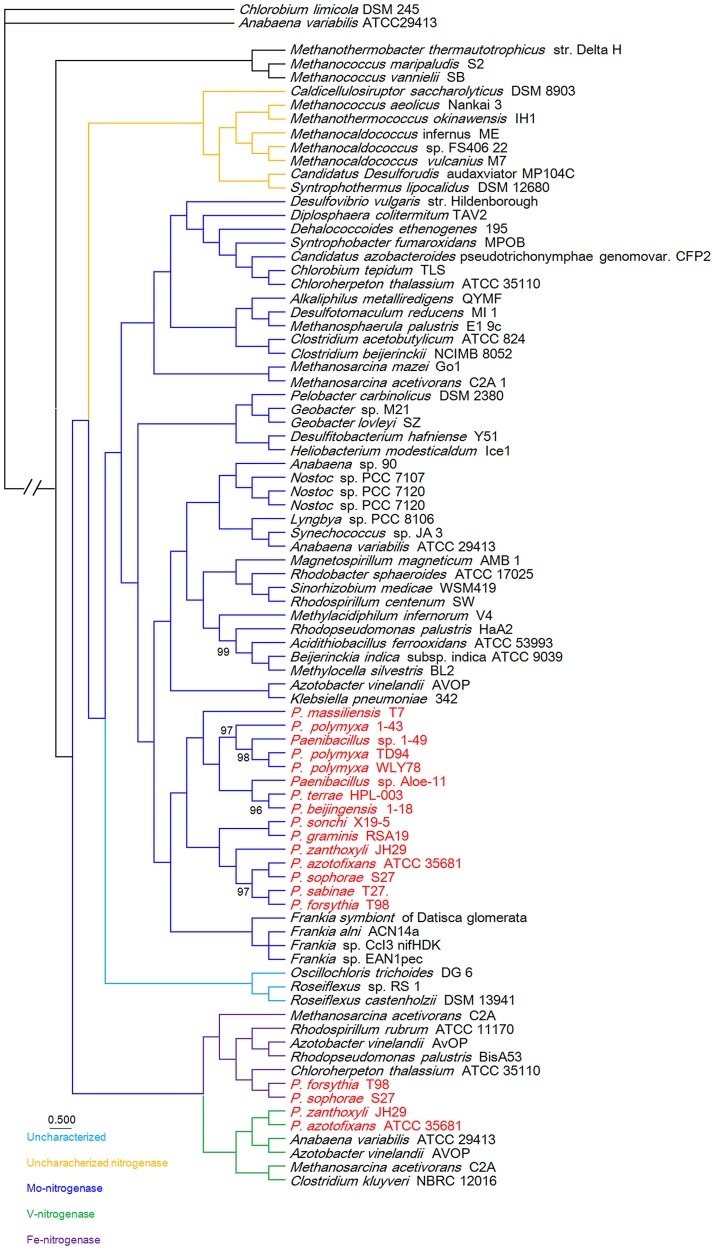
Bayesian inferred phylogenetic tree of concatenated NifHDK homologs.The interior node values of the tree are clade credibility values, values lower than 100% are indicated. Branches are colored blue (Mo-nitrogenase, Nif), green (V-nitrogenase, Vnf), purple (Fe-nitrogenase, Anf), light blue (uncharacterized homolog), dark yellow (uncharacterized nitrogenase). The text colored red was Paenibacillus.